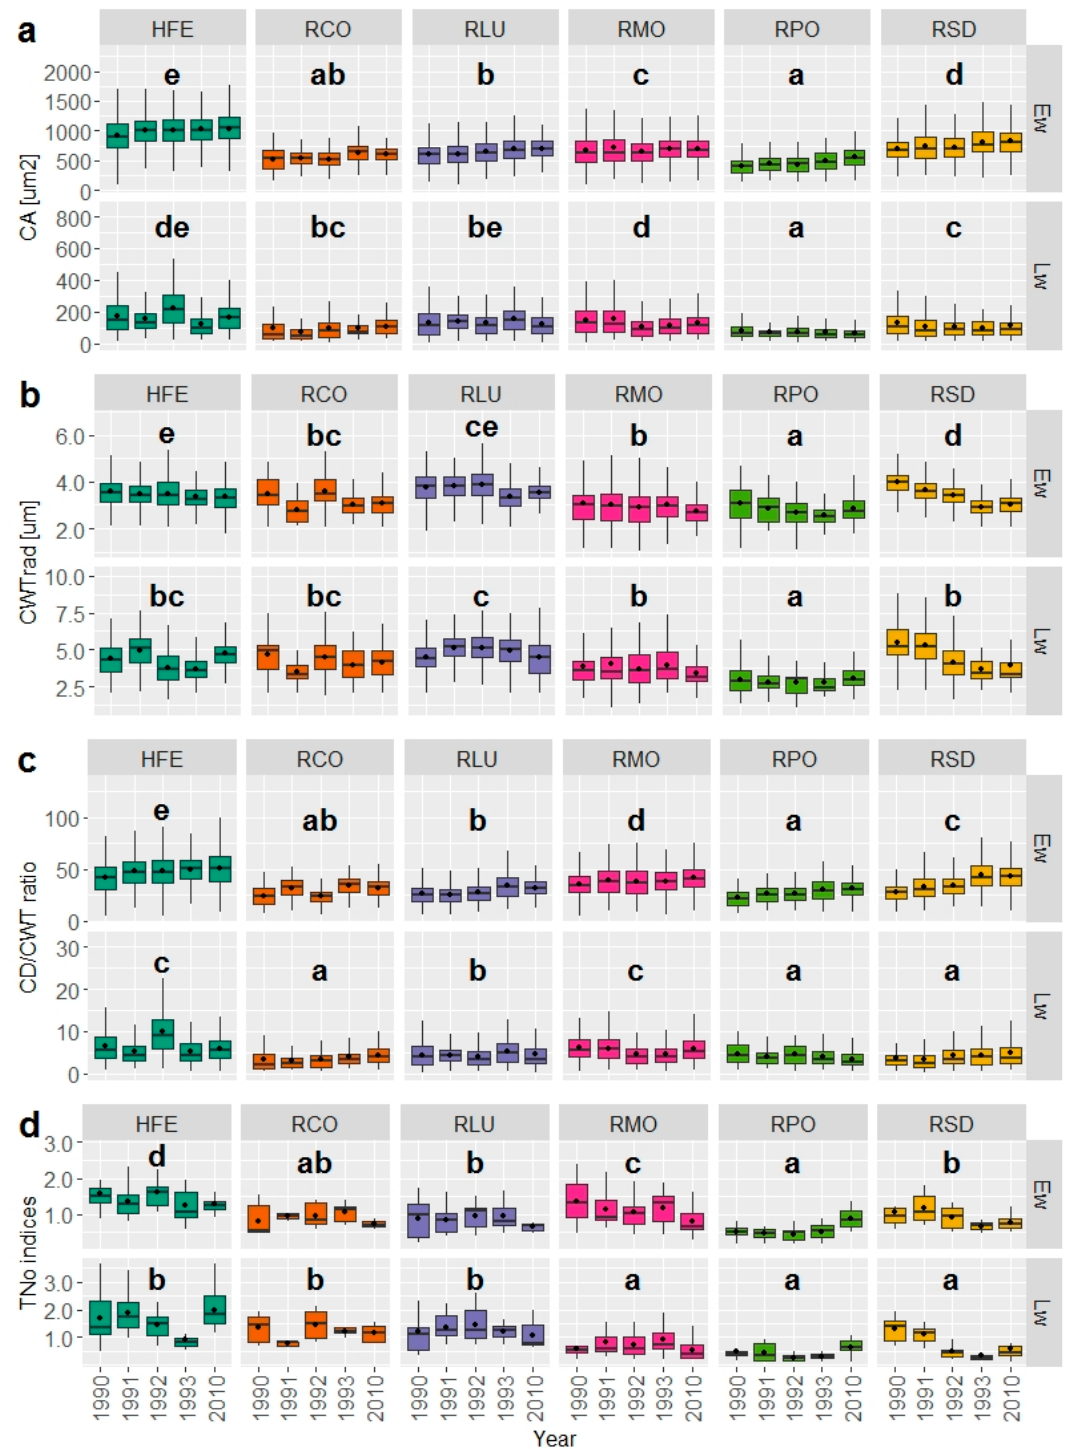
Figure 4. Boxplots (displaying minimum, first quartile, median, third quartile, maximum and mean) of the four measured wood anatomical features of trunk cross sections in earlywood (Ew) and latewood (Lw) from the sampled sites (HFE-RSD) for each studied year (1990–2010): CA cell area ( a ); CWTrad radial cell wall thickness ( b ); CD/CWT ratio of the cell diameter and radial cell wall thickness ( c ); TNo indices standardized tracheid number within a tracheid file ( d ). Tukey’s HSD significant differences between sites are indicated with letters, pooled over the studied years. In the latewood, sites had significant effects on the four measured parameters of CA, CWTrad, CD/CWT and TNo (all with p < 0.001; Table 2). RPO displayed significantly